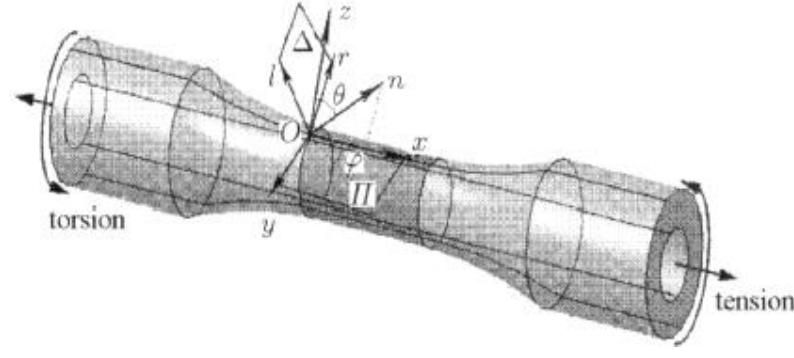
Figure 6. Specimen made of aluminum alloy LY12CZ [29]. Fatigue strength and material parameters of S–N curvilinear equation of aluminum alloy